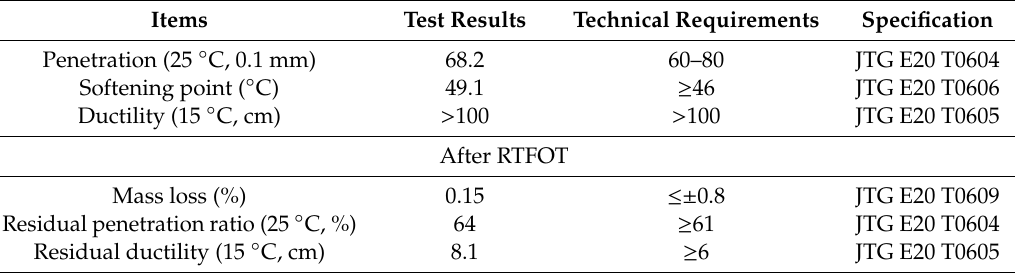
Table 1. Technical properties of PG 70 base asphalt.